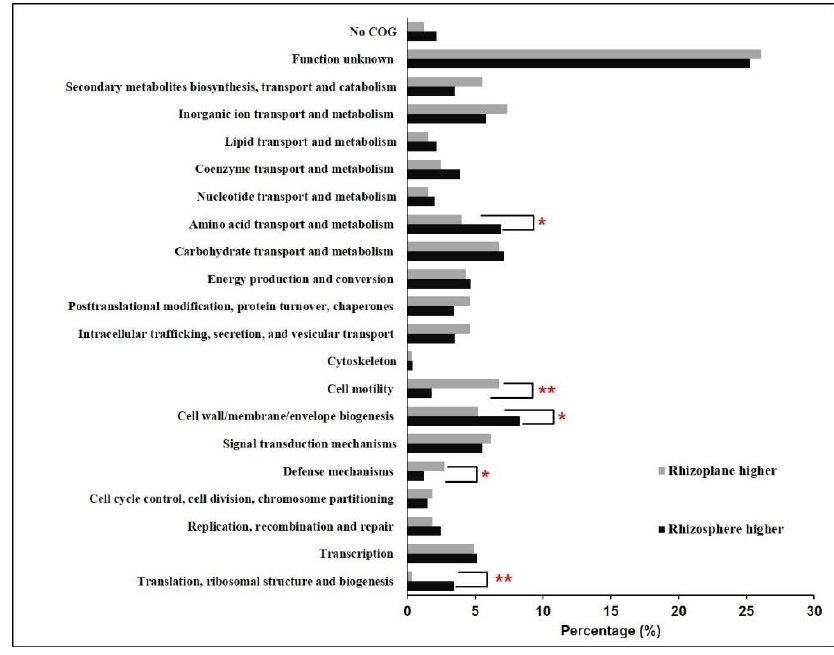
Figure 4. Functional distribution of the Cellvibrio sp. Bin79 differentially expressed genes between the rhizoplane and rhizosphere. *, p < 0.05; **, p < 0.01, determined by one-tailed Fisher’s exact test.